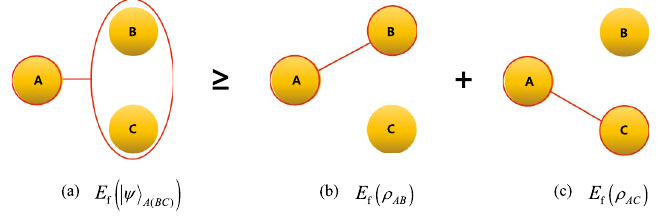
Figure 1. The entanglement between A and BC quantified by E f summation of the entanglement between A and B quantified by E f (ρ AB ) (( b ) in the figure) and the entanglement between A and C quantified by E f (ρ AC ) (( c ) in the